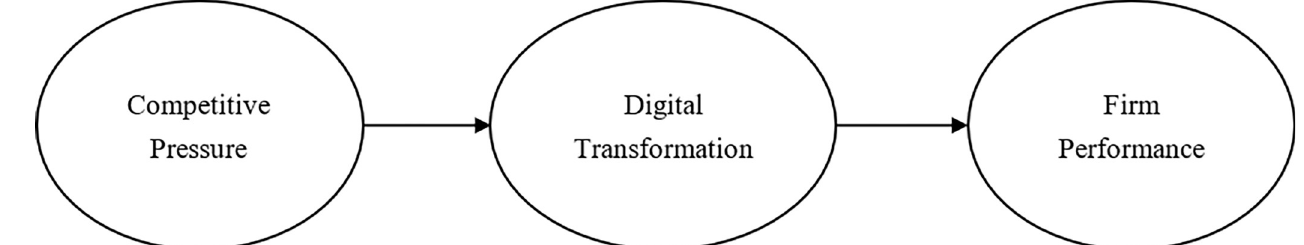
Fig 1. The research model in Study 1.